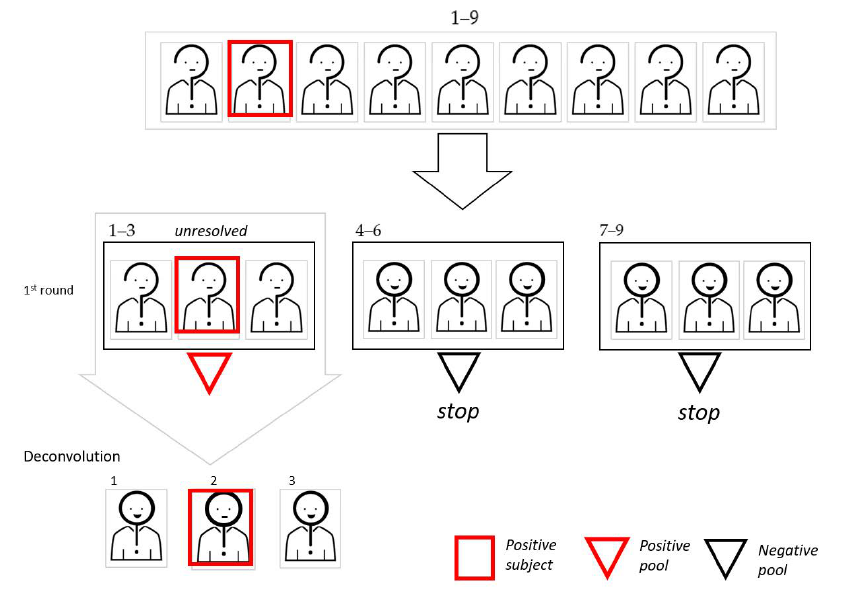
Figure 1. Graphic representation of the mono-dimensional (1D) pooling approach. In this example, the cohort dimension is 9, the pool size is 3, and the virus frequency, vf, is 0.10. To begin, aliquots of the nine samples are used to create three pools. Since two pools result as negative, we can exclude six subjects. The remaining three subjects of the pool that tested as positive are retested